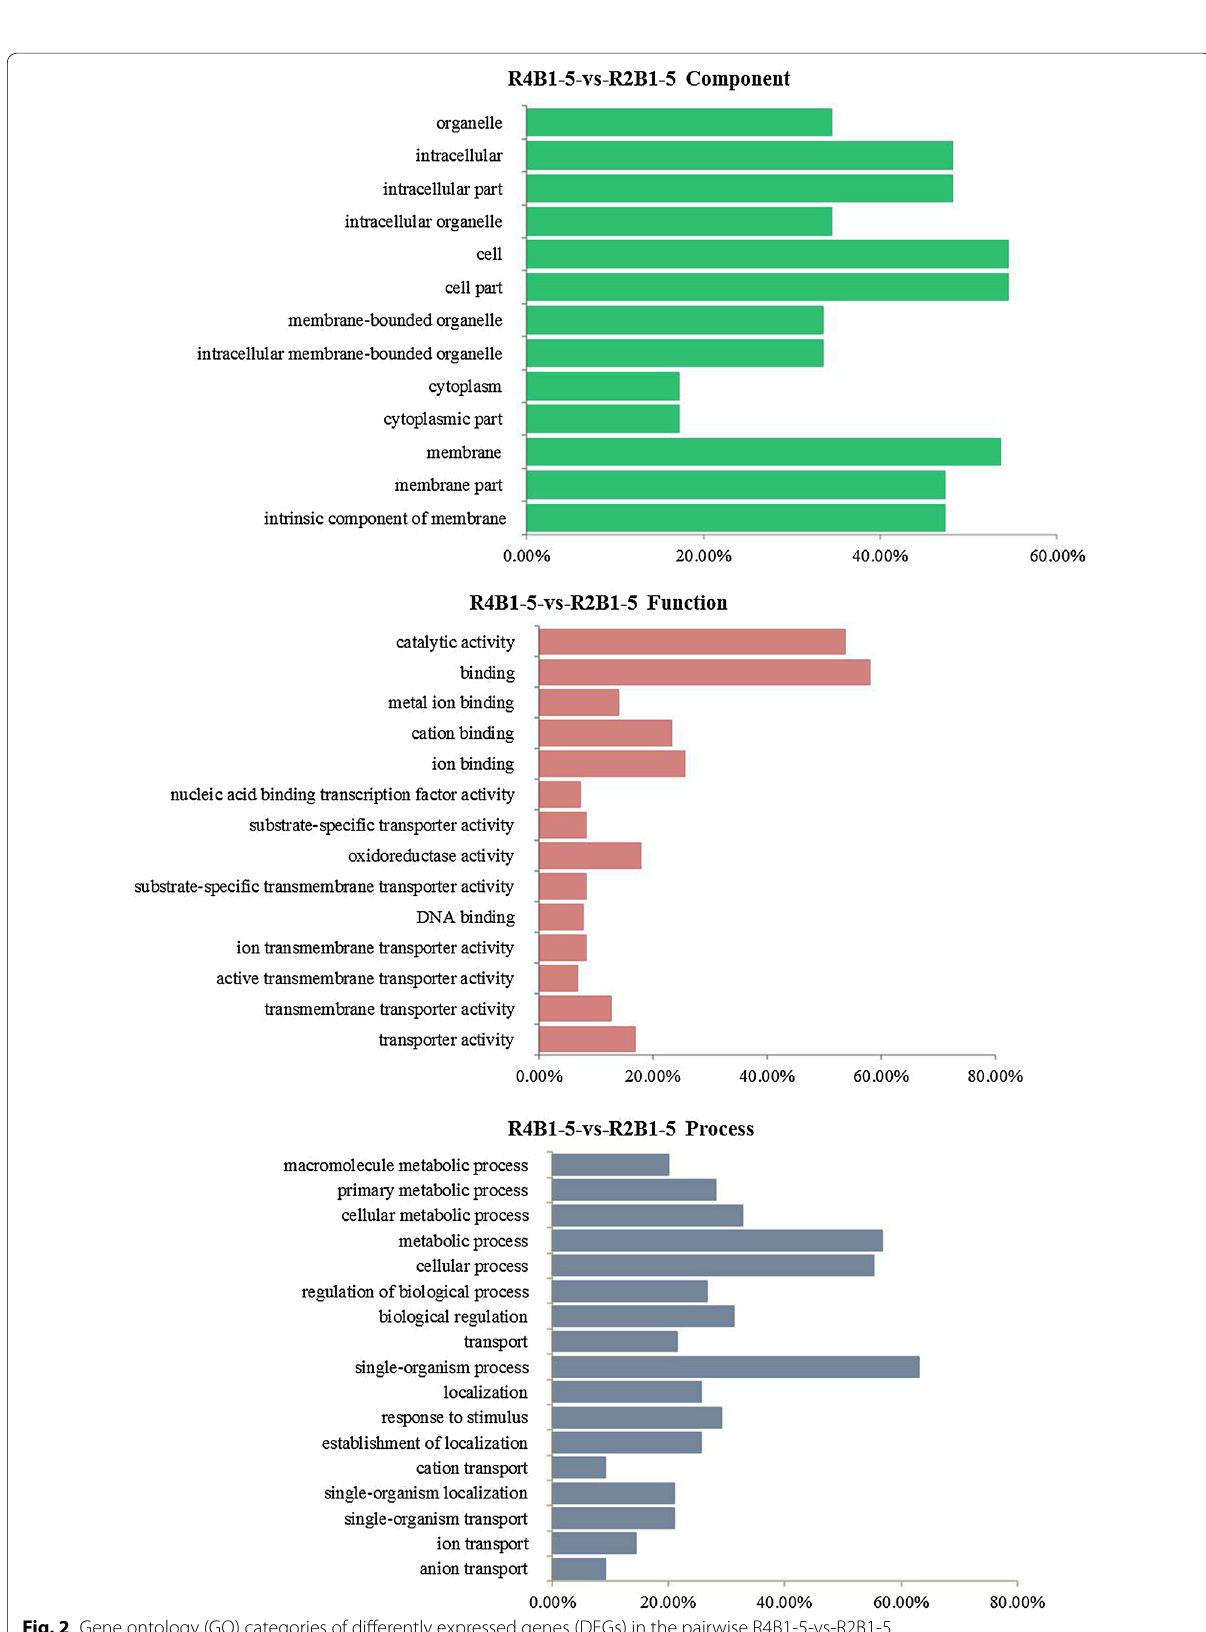
Fig. 2 Gene ontology (GO) categories of differently expressed genes (DEGs) in the pairwise